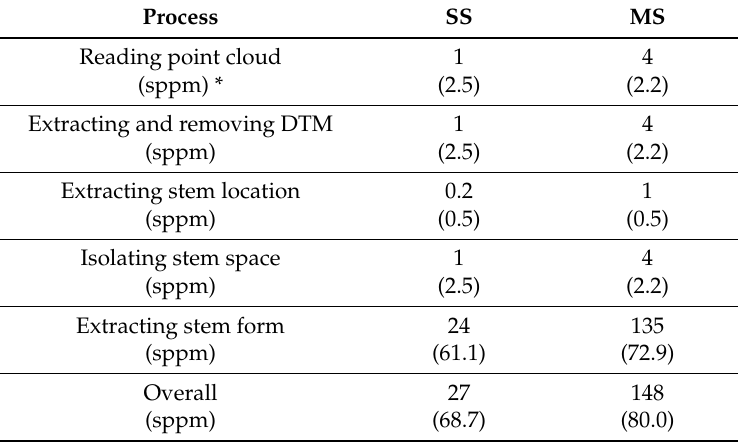
Table 3. Time distribution in the automation algorithms in